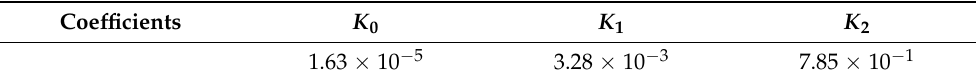
Table 2. Coefficient of the temperature